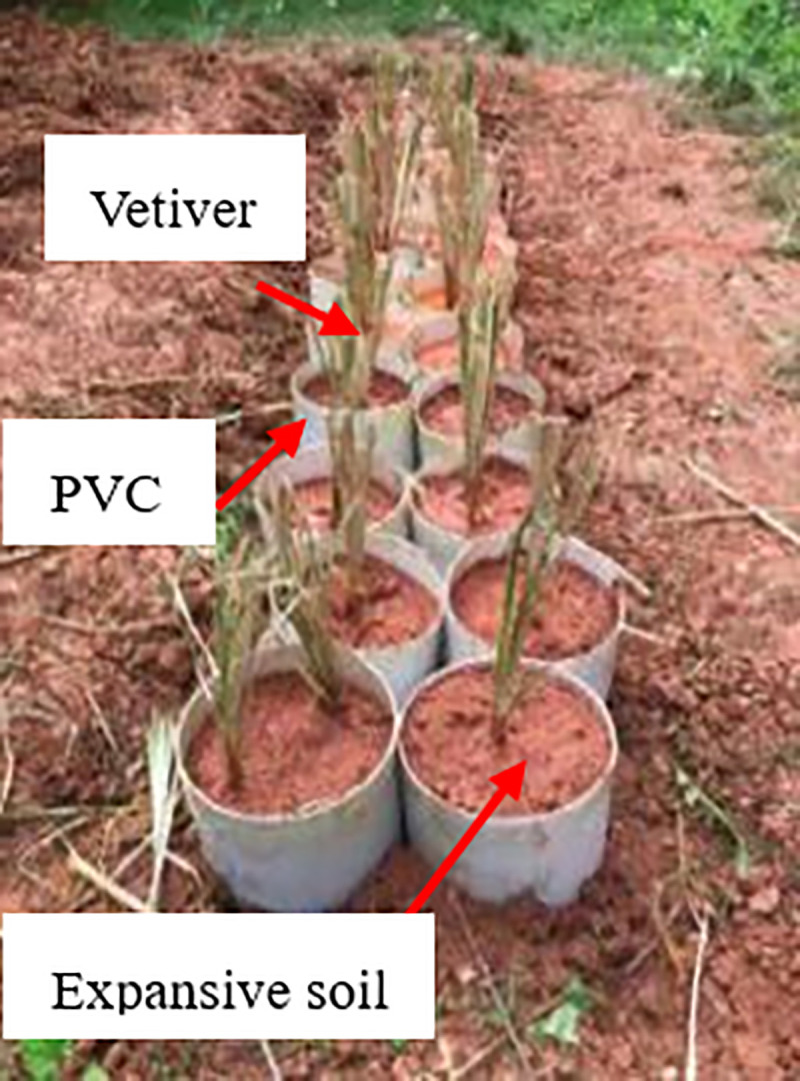
Vetiver cultivation.